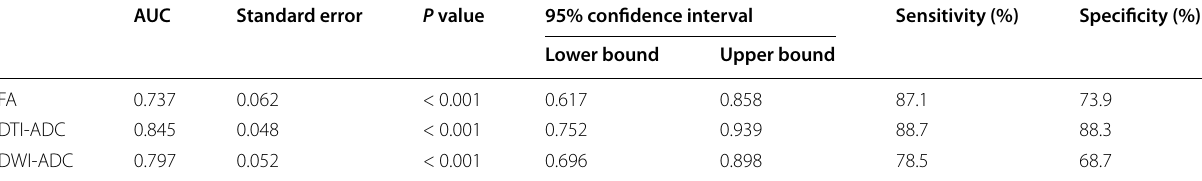
Table 5 AUC and 95% confidence interval for FA, DTI-ADC and DWI-ADC